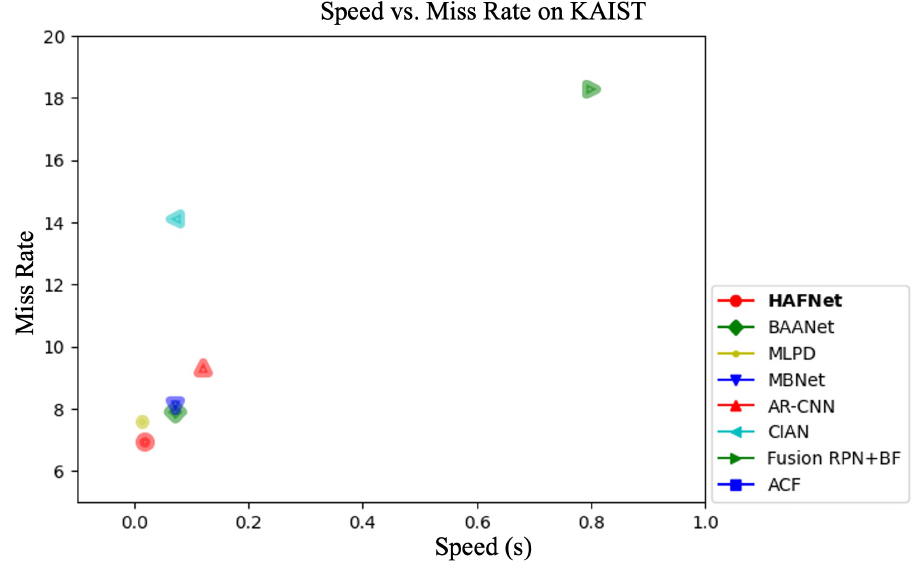
Figure 6. Miss rate versus the speed of our proposed HAFNet. HAFNet achieves excellent perfor- mance in terms of speed and miss